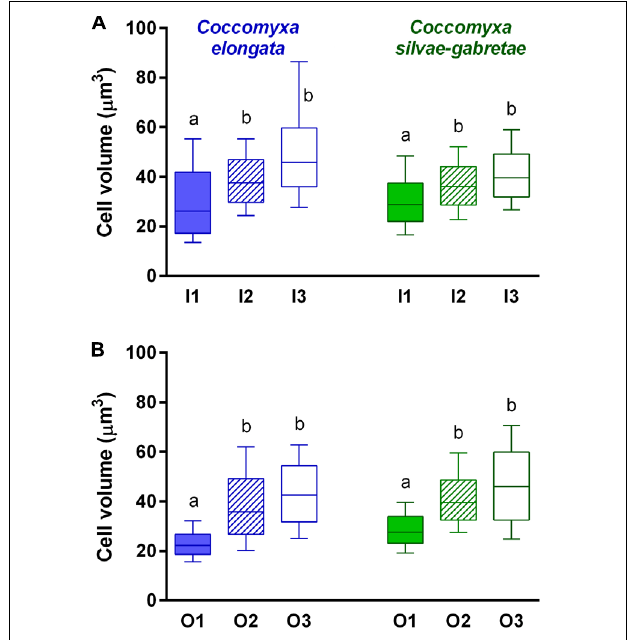
FIGURE 3 | Comparison of mean cell volume of the Coccomyxa cultures in P-replete (1) and P-depleted (2 and 3) media with either inorganic (I; top: A ) or organic (O; bottom: B ) P source. Box and whisker plots show medians (bar), 25 and 75% quartiles (box), and 10–90% percentiles (whiskers); note same scales. Differences among treatments were tested using three-way ANOVA with a post hoc Tukey HSD test; lower case letters above the columns (a, b) indicate significant differences among treatments (see Table 2 for summary